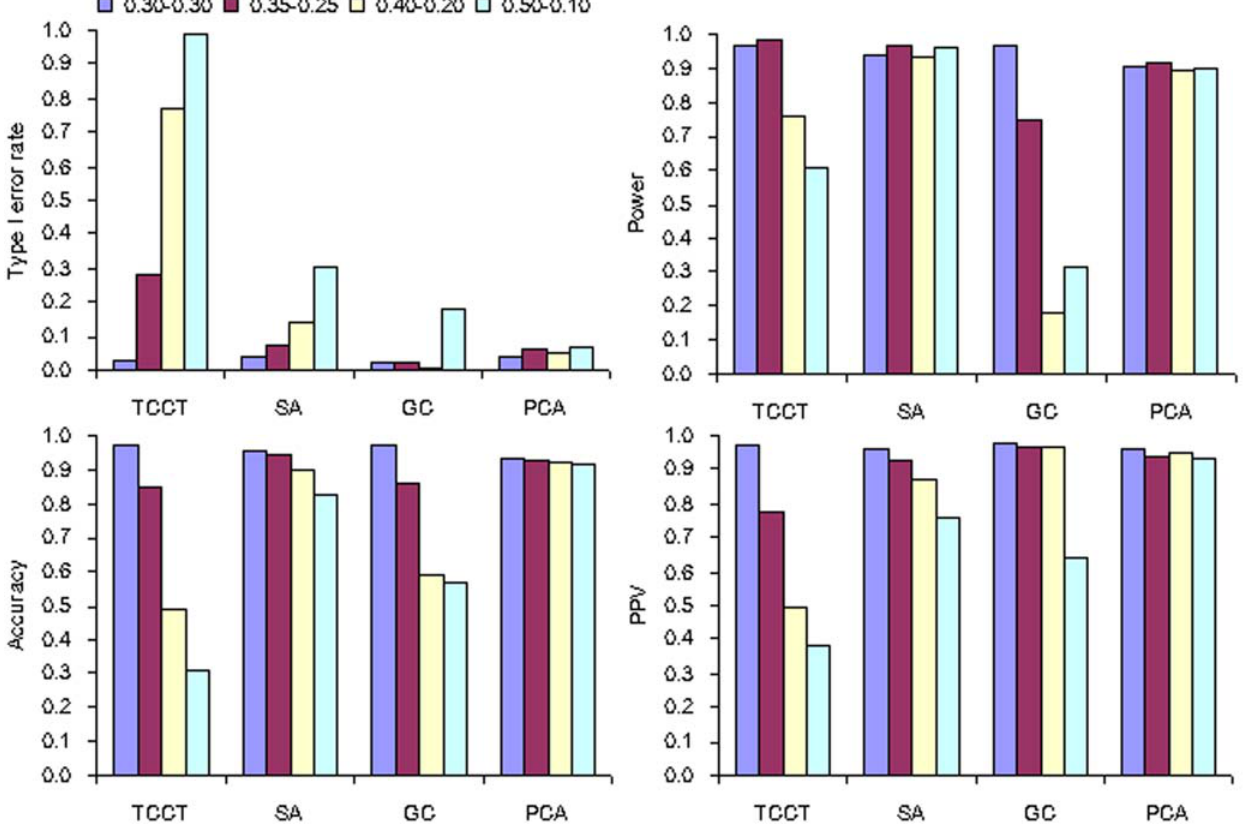
Figure 1. Performance of the four analytical methods in stratified populations with stratification levels varying from 0.3 2 0.3 to 0.5 2 0.1 (sample size=1200, frequency of disease susceptible allele=0.20 6 0.02 and number of AIMs=40).